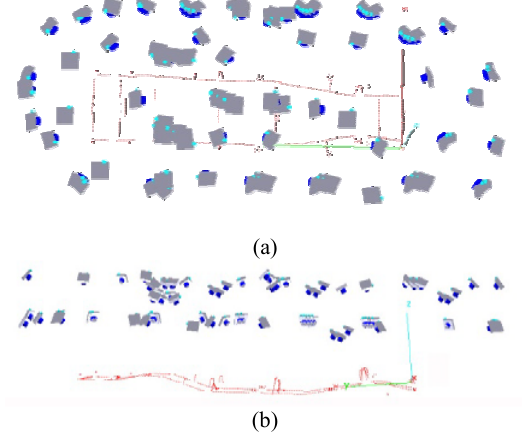
Figure 5. Numbers of observations for start and end of scale bars in main chassis (1) and produced one